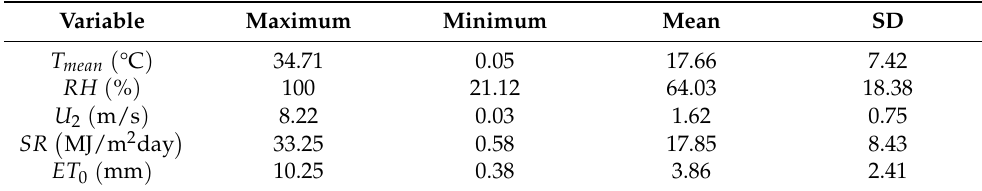
Figure 1. Meteorological time series and reference evapotranspiration. ( a , c , e , g , i ) Original series. ( b , d , f , h , j ) Daily anomalies of time series. ( a , b ) Mean temperature ( T mean ). ( c , d ) Relative humidity ( RH ). ( e , f ) Wind speed at 2 m heigh ( U 2 ). ( g , h ) Solar radiation ( SR ). ( i , j ) Reference evapotranspiration ( ET 0 ). Table 1. Statistical properties of the agro-meteorological time series.